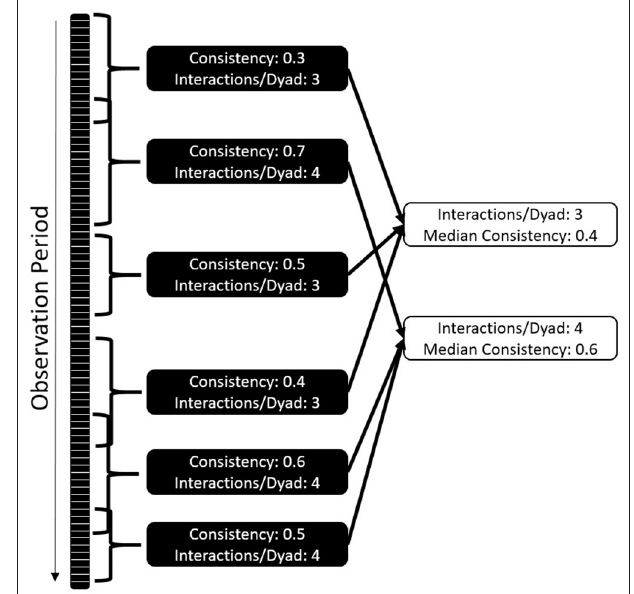
FIGURE 2 | Standardization of consistency as a comparative measure: each dataset is randomly cut into shorter time windows of changing size and starting point. Consistency and amount of interactions per dyad are established. The median of consistencies across different interactions per dyad values are established. The comparative value is the number of interactions per dyad where the consistencies cross